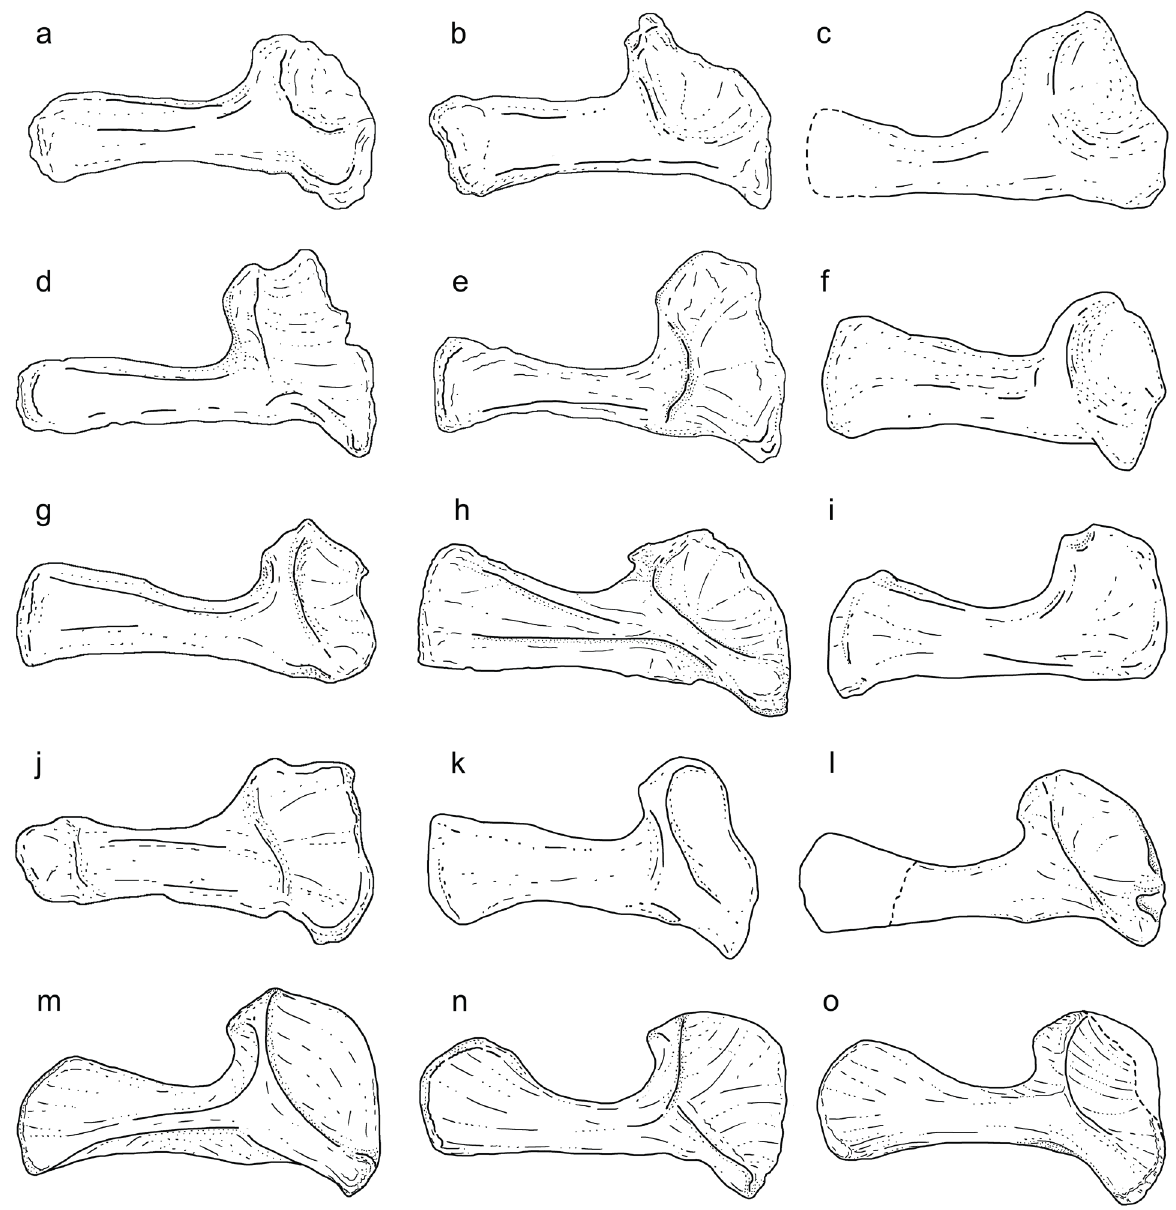
Figure 2 – Morphological comparison of right scapulae of titanosaurians ( a - k ) versus those of other sauropods ( l - o ) in lateral view. South American (Argentinean) taxa denoted with an asterisk. ( a ) Pitekunsaurus macayai *, redrawn from Filippi and Garrido (2008), ( b ) Rapetosaurus krausei , redrawn from Curry rogers (2009), (c) Choconsaurus baileywillisi* , redrawn from Simón et al. (2018), ( d ) Dreadnoughtus schrani * (left, reversed), redrawn from Lacovara et al. (2014), ( e ) Muyelensaurus pecheni *, redrawn from Calvo et al. (2007c), ( f ) Saltasaurus loricatus *, redrawn from Powell (1992), ( g ) Mendozasaurus neguyelap *, redrawn from González riga et al. (2018), ( h ) Patagotitan mayorum *, redrawn from Carballido et al. (2017), ( i ) Drusilasaura deseadensis * (reversed), redrawn from Navarrete et al. (2011), ( j ) Opisthocoelicaudia skarzynskii , redrawn from Borsuk-Bialynicka (1977), ( k ) Elaltitan lilloi* , redrawn from Mannion and Otero (2012), ( l ) Mamenchisaurus youngi (left, reversed), redrawn from Ouyang and Ye (2002), ( m ) Diplodocus carnegii (left, reversed), redrawn from hatcher (1901), ( n ) Giraffatitan brancai (left, reversed), redrawn from Janensch (1961), ( o ) Camarasaurus supremus (left, reversed), redrawn from Osborn and Mook (1921). Not to